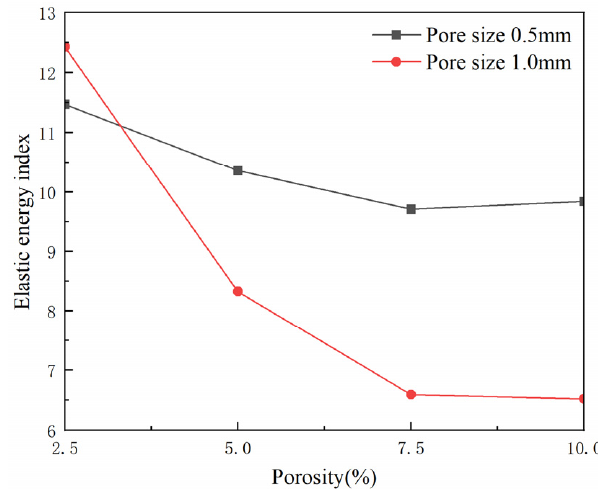
Figure 16. Statistical graph of elastic energy index in coal rock model. To investigate the mechanism of the effect of pore structure on the impact energy index of coal rock models, elastic energy index tests and uniaxial compression tests were performed on two models with different pore characteristics. Figure 17 shows the test results for the two materials, where the pore characteristics of material 1 were 10% poros- ity, pore size 1.5 mm, while material 2 was a non-porous numerical model with similar compressive strength. In Figure 17, the area enveloped by the acceleration-unloading curve is the plastic strain energy, which indicates the energy consumed by destruction of the internal material primitive and crack extension. It can be seen that more energy was consumed by material 1. Figure 18 shows the first half of the stress–strain curves of the two materials, where H and K are the extensions of the elastic part of the lines of materials 1 and 2, respectively. The model is considered to start plastic deformation when it starts to separate from the stress–strain curve. L denotes the 80% peak stress line, whose intersection with the stress–strain curve is the extreme value point of the stress during loading in the elastic energy index measurement experiment. Due to the stress concentration phenomenon around the pores inside the model during loading, damage occurred earlier in the primitives around the pores. Figure 18 depicts the earlier plastic deformation of material 1. It can be seen from Figure 18 that the deformation of material 1 was higher after stress loading to 80% of the peak, as material 1 produced more initial and secondary cracks. The damage to the internal primitives was more serious. The damage to the primitives in the material and the generation and expansion of cracks all released a certain amount of energy, dramatically weakening the model’s ability to accumulate deformation energy. In the second half of the experiment, when the stress was unloaded, this part of the damaged primitive lost its ability to recover from the deformation. At the same time, the frictional force between the cracks inside the model inhibited the rebound of the material, such that the deformation of the material could not be fully recovered. Most of the work done by the external force on the model is absorbed by the crack closure and slip and, so, the plastic strain energy of material 1 in Figure 17 was much higher. Compared with the coal rock model with low porosity and small pore size, the high porosity and large pore size model had a more obvious stress concentration phenomenon during loading, and produced more initial cracks and secondary cracks, thus weakening the model’s ability to accumulate energy and rebound to a greater extent and having a more significant impact on the elastic energy